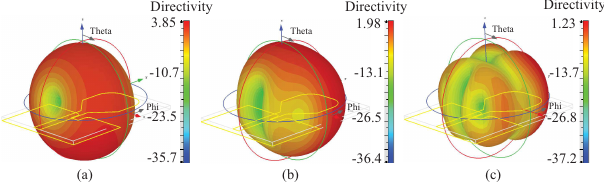
FIGURE 9: 3D radiation patterns at: (a) 3 GHz. (b) 6 GHz. (c) 10 GHz.